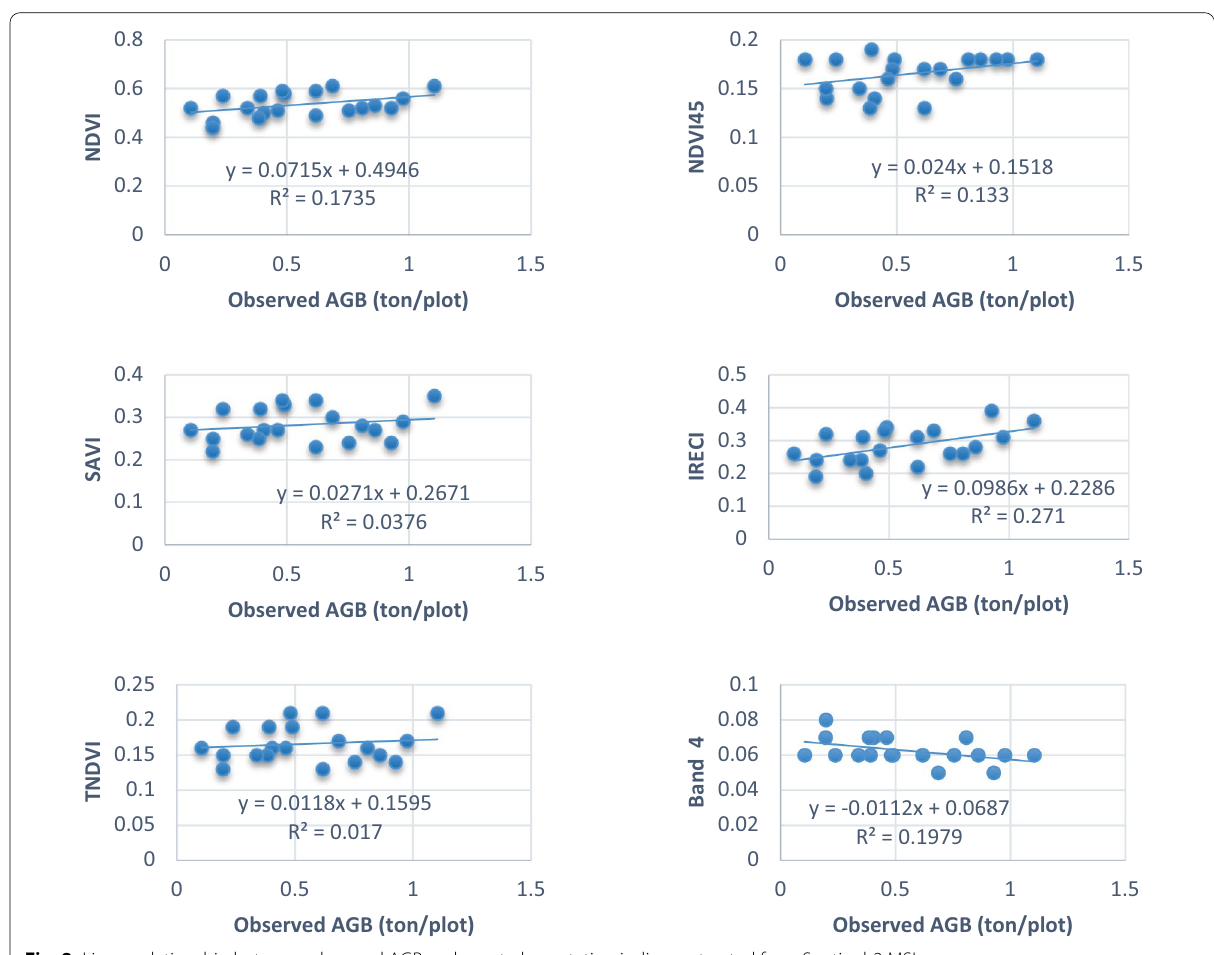
Fig. 8 Linear relationship between observed AGB and spectral vegetation indices extracted from Sentinel-2